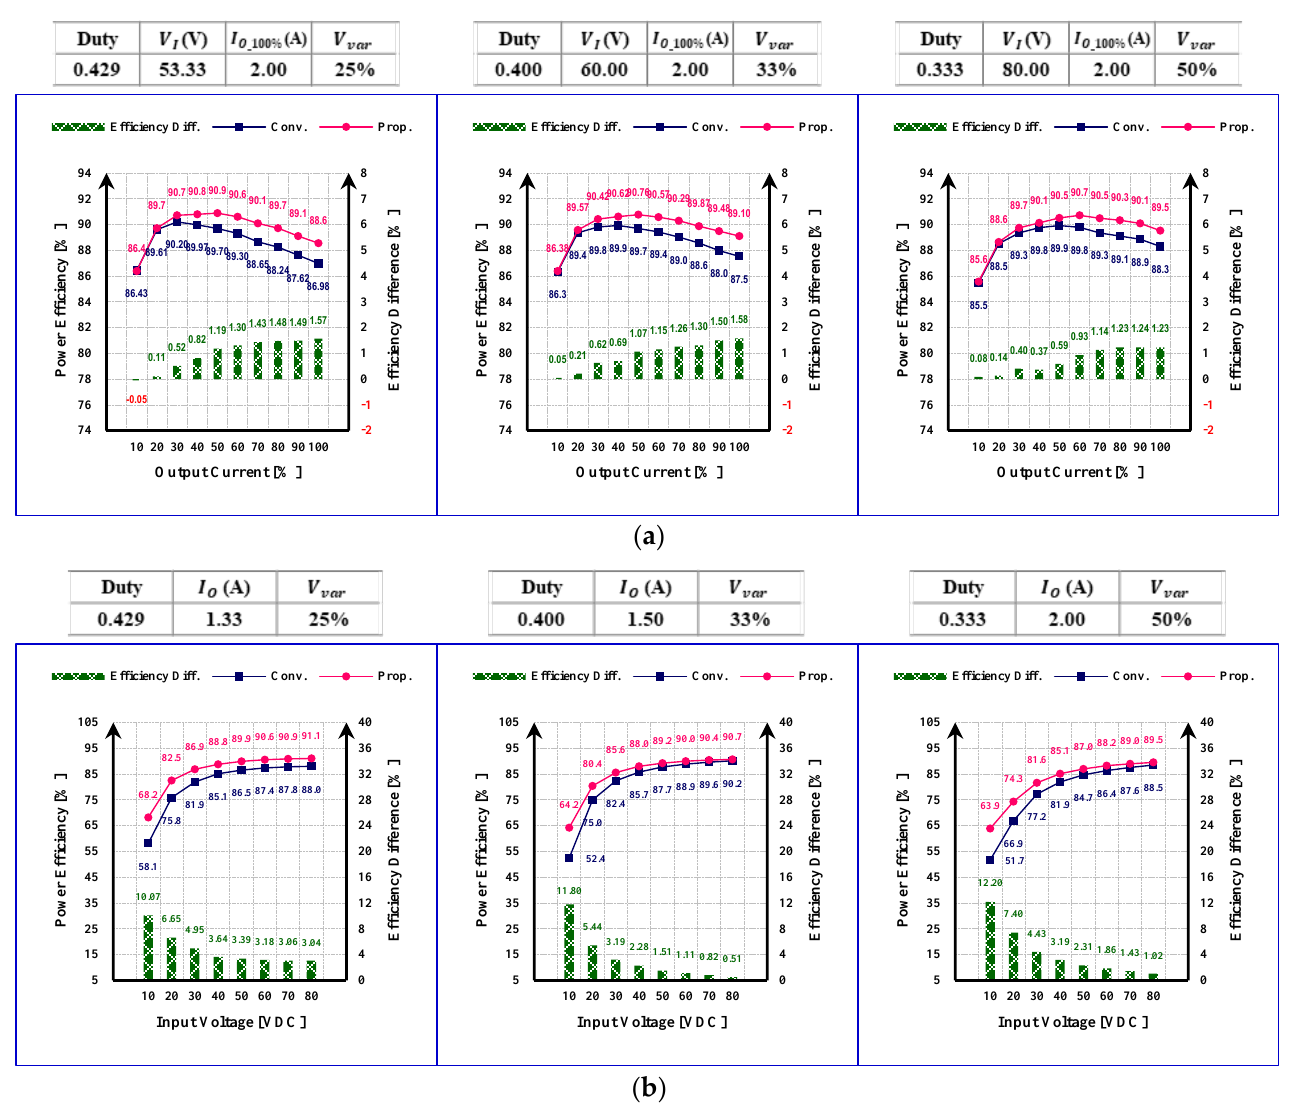
Figure 11. Power efficiency comparison of the buck-boost topology (step-down): ( a ) CV mode; ( b ) CC mode.